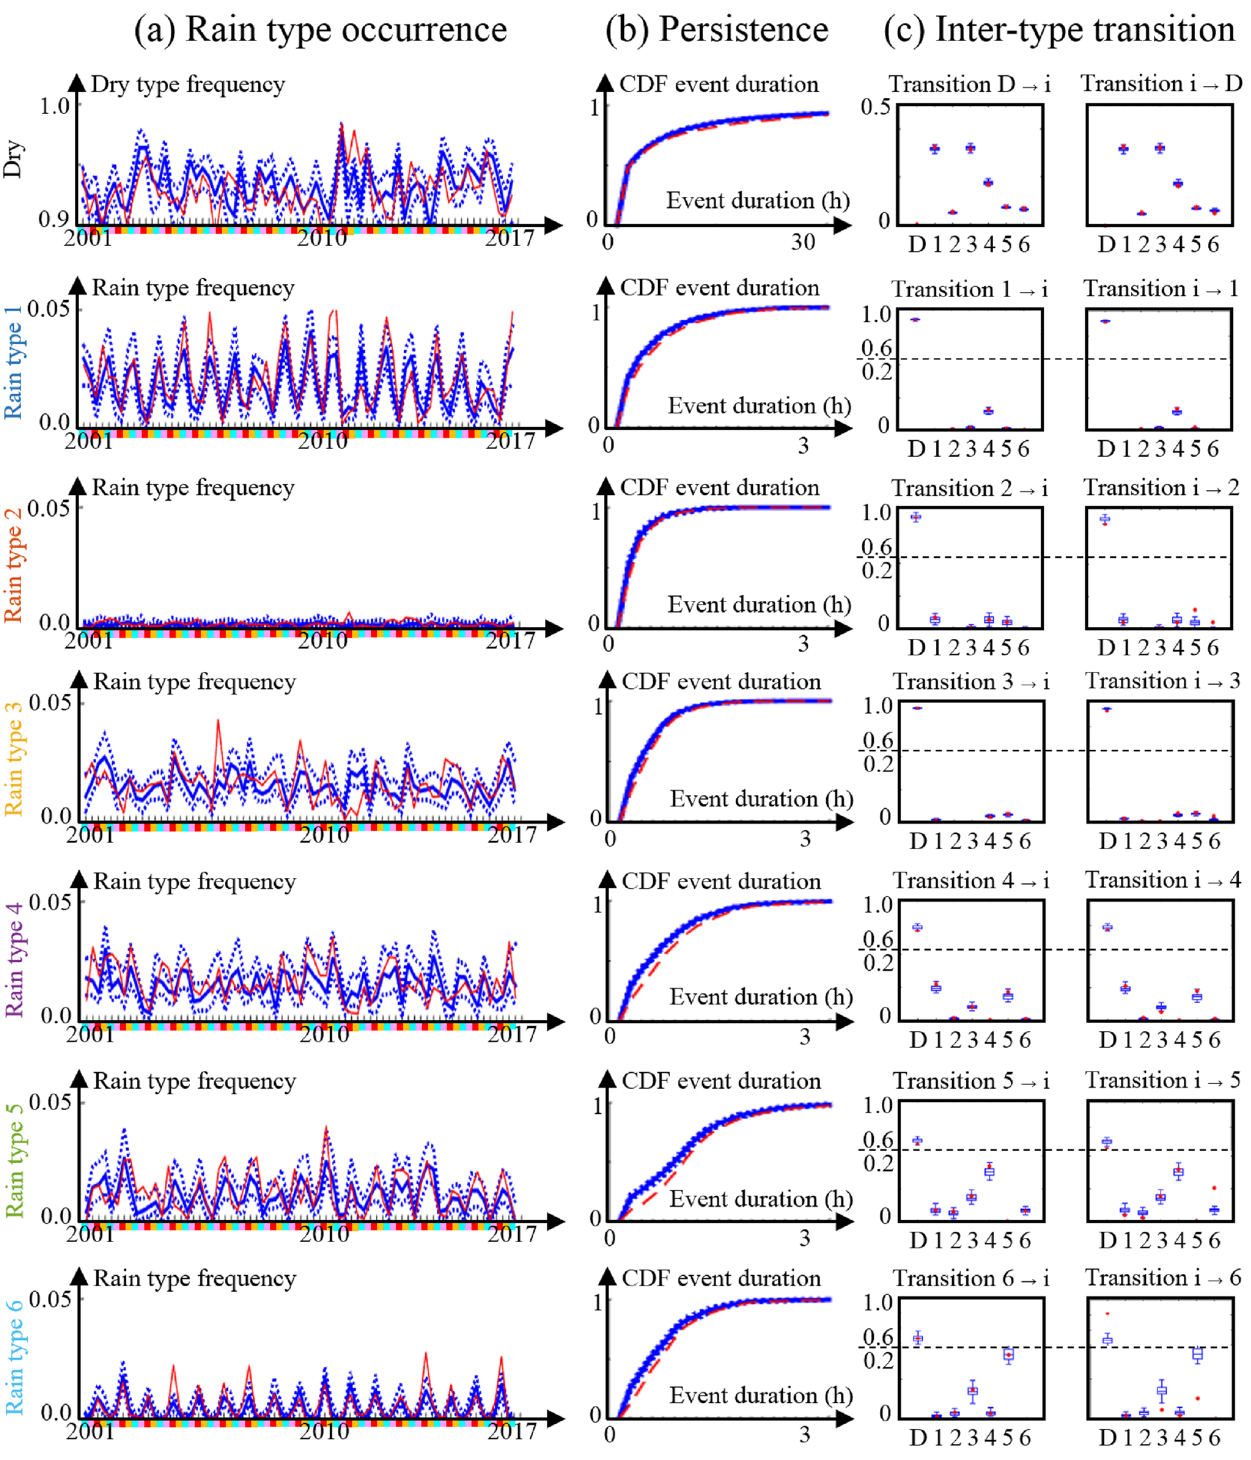
Figure 6. Results of the cross-validation experiment. (a) Seasonality of rain (and dry) type occurrence (seasons are DJF in light blue, MAM in pink, JJA in red and SON in yellow), (b) rain type persistence and (c) probability of transition between rain types. Observations are in red, and simulations are in blue. In simulations, continuous lines represent the median of the simulated ensembles (50 realizations), and dashed lines represent the Q 10 and Q 90